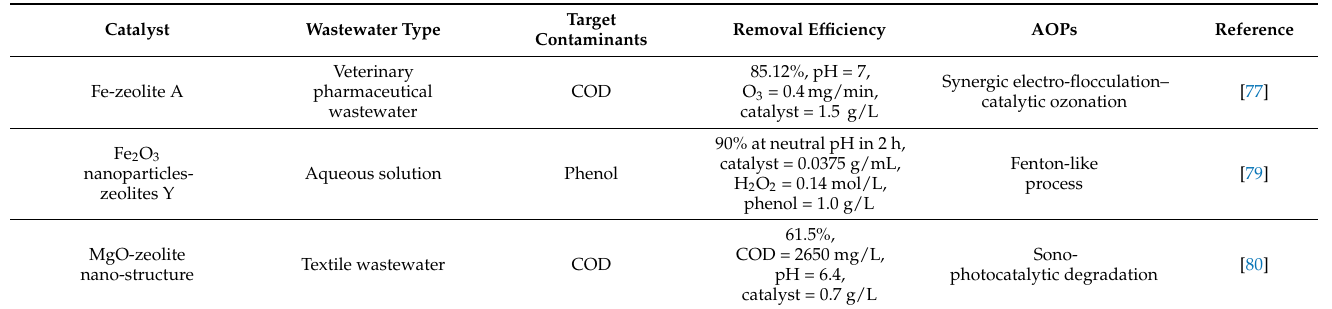
Table 6. Zeolites used as nanocatalysts in AOPs for wastewater